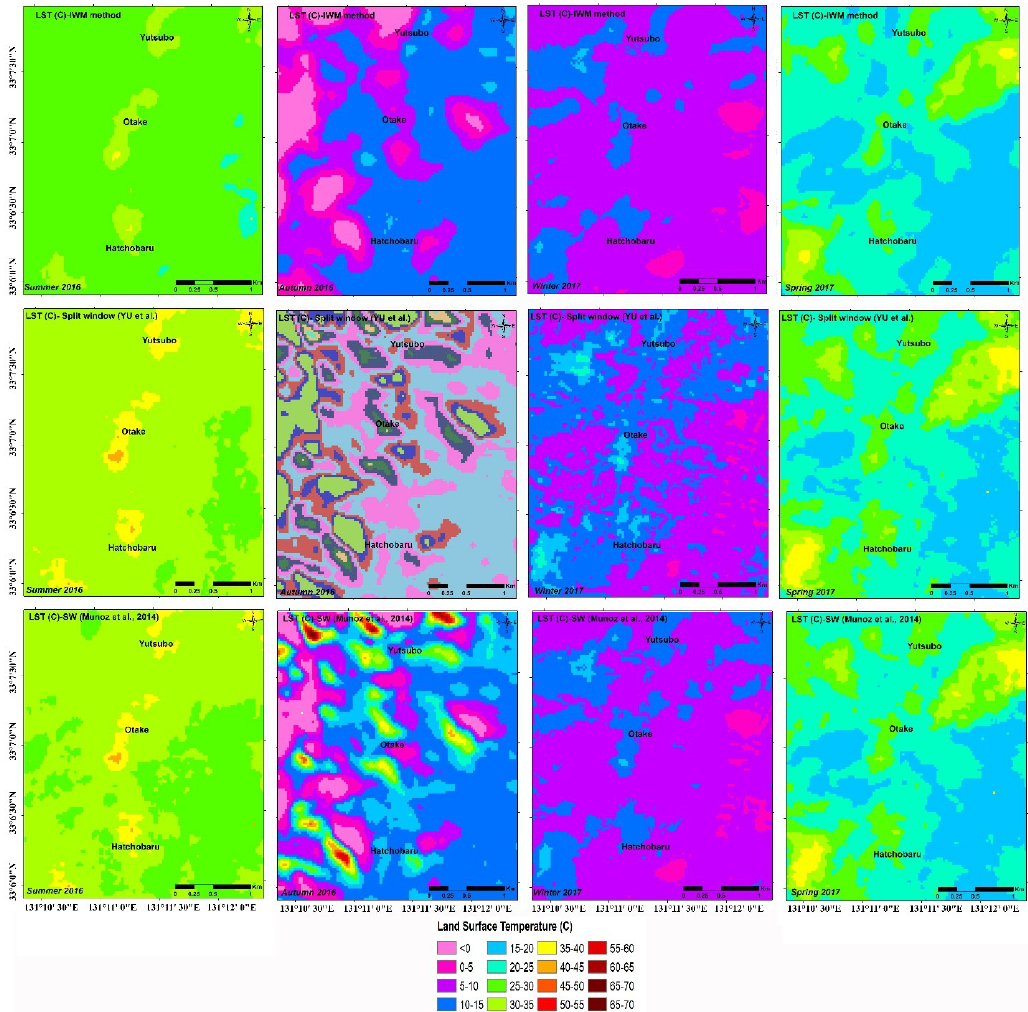
Figure 15. Seasonal land surface temperatures (LST) within the study area derived from daytime Landsat 8 thermal infrared data. The LSTs of each season processed using the improved mono-window (IMW) algorithm are shown in the top row; the LSTs of each season processed using the split window (SW) algorithm of Yu et al. [19] are shown in the middle row; while the LSTs for each season processed using the SW algorithm of Jiménez-Muñoz et al. [20] are shown in the bottom row. Seasons are arranged in the order of summer, autumn, winter, and spring, in all of the rows.